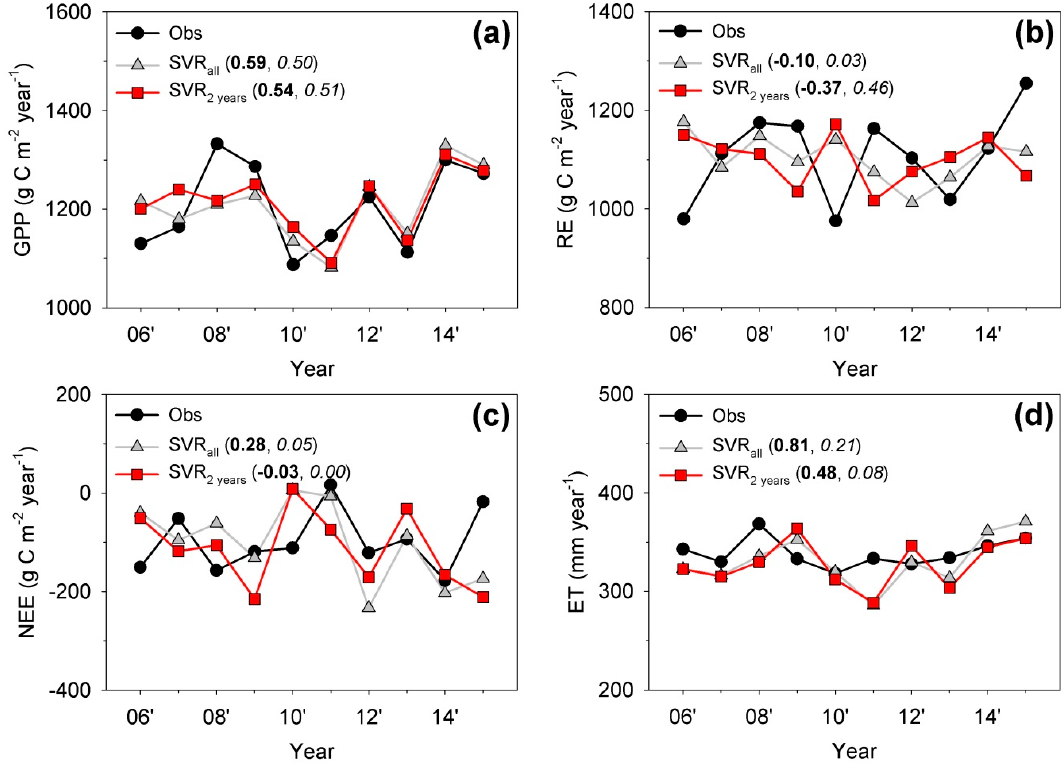
Figure 9. Same as Figure 8 (GPP ( a ), RE ( b ), NEE ( c ), and ET ( d )), but for the Gwangneung deciduous forest in the Korea National Arboretum (GDK) site from 2006 to 2015.